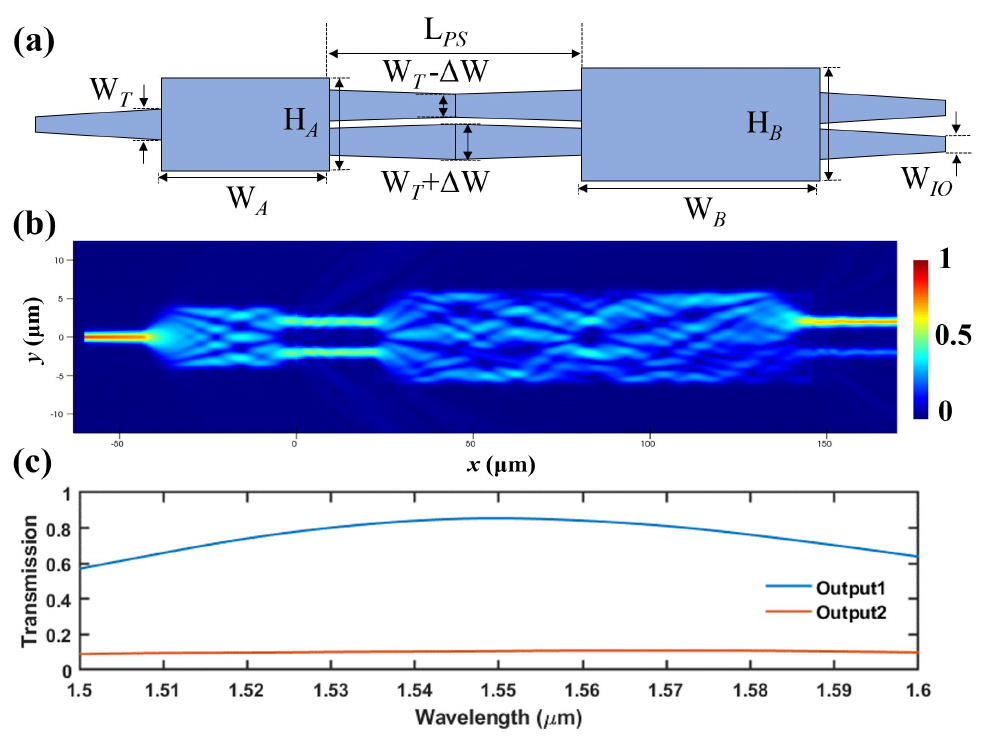
Figure 2. ( a ) Schematic view of the arbitrary ratio optical splitter with design parameters labeled. ( b ) Simulated mode profile of the arbitrary ratio optical splitter at 1550 nm. ( c ) Simulated spectral transmission at the output ports. The above results were obtained using Lumerical FDTD